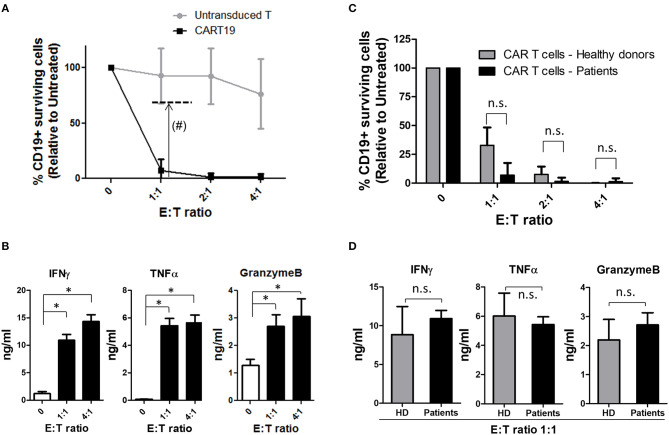
ARI-0001-cell potency. (A) Cytotoxicity assay after 4 h of ARI-0001 co-culture with NALM6 cells, at the indicated ratios. Mean ± SD of all 27 CAR T cell products is indicated. (#) Dashed line indicates minimum of ARI-0001-cell cytotoxicity level for a product to be considered valid. (B) IFNγ, TNFα, and GranzymeB levels measured in the supernatants of the cytotoxicity assays. E:T ratio 0 indicates no target cells. (*) indicates statistical significance, p < 0.05. (C) Comparison of ARI-0001 cytotoxic potential after 4 h of co-culture with NALM6 cells, at the indicated ratios. Mean ± SD is shown. “n.s.” indicates not statistically significant (Non parametric test). (D) Comparison of IFNγ, TNFα, and GranzymeB levels measured in the supernatants of the cytotoxicity assay at E:T ratio 1:1. “HD” indicates Healthy donors. “n.s.” indicates not statistically significant (Parametric test applied to IFNγ and TNFα and non-parametric test applied to GranzymeB).